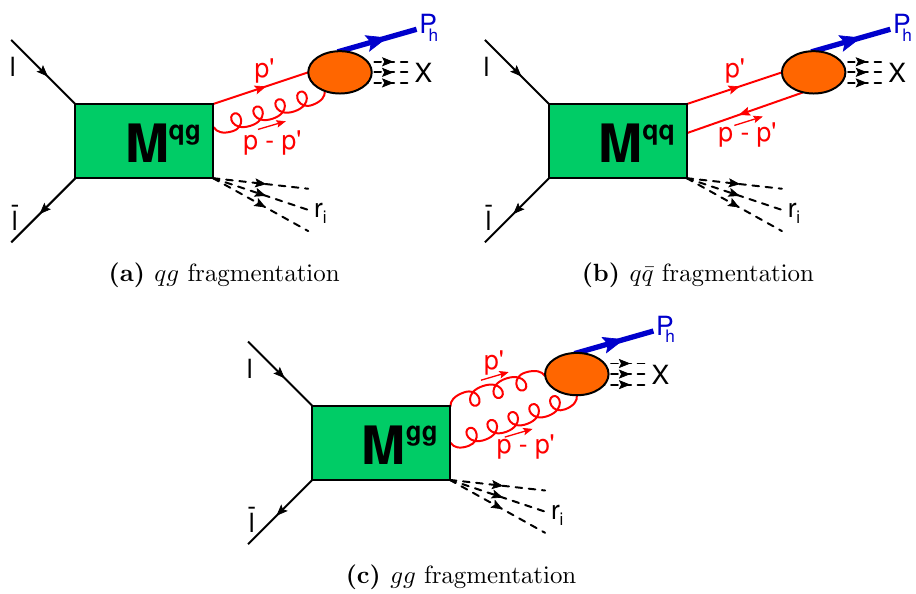
Figure 4. Fragmentation mechanism in e + e (cid:0) annihilation for dynamical